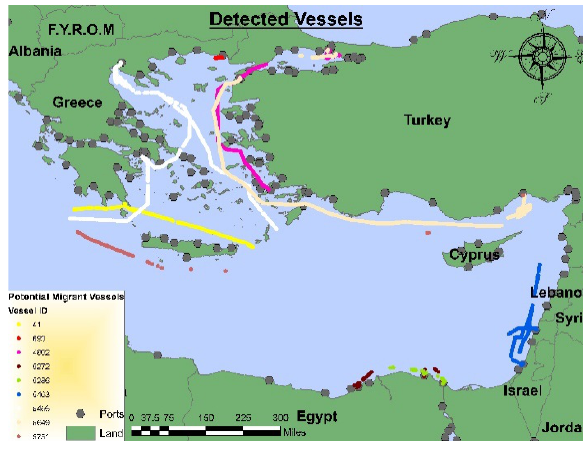
Figure 8 . Detected Vessels